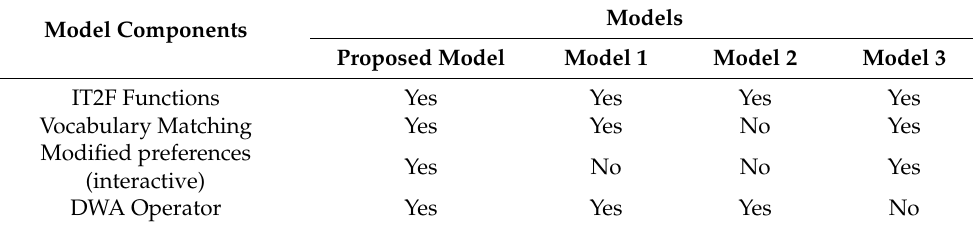
Table 14. Di ff erent model